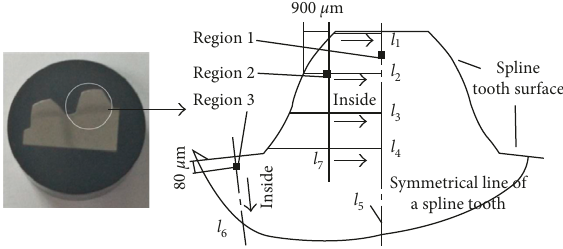
Figure 2: Schematic illustration of the test regions.